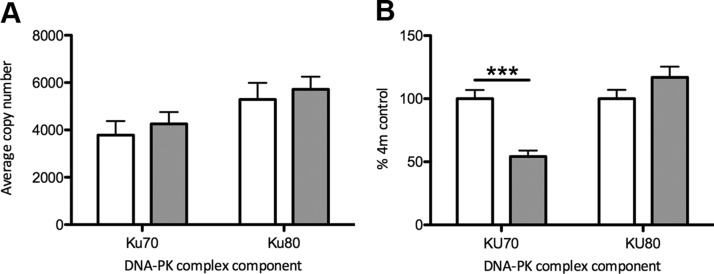
Effect of gestational hypoxia compared to normoxia on expression of components of the DNA-PK in the ovary. Data shown as means ± sem. Open bars normoxia (21% oxygen) during gestation; gray bars: hypoxia (13% oxygen) during gestation. A) Gene expression. B) Protein expression. Protein expression is represented as the percentage of the 4-mo normoxia group (assigned baseline value of 100%). ***P < 0.001.